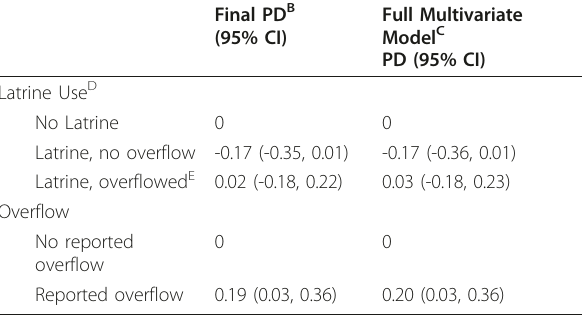
Table 2 Water and sanitation infrastructure and household prevalence of diarrhea in the North Atlantic Autonomous Region, Nicaragua, 2009 (N = 189).